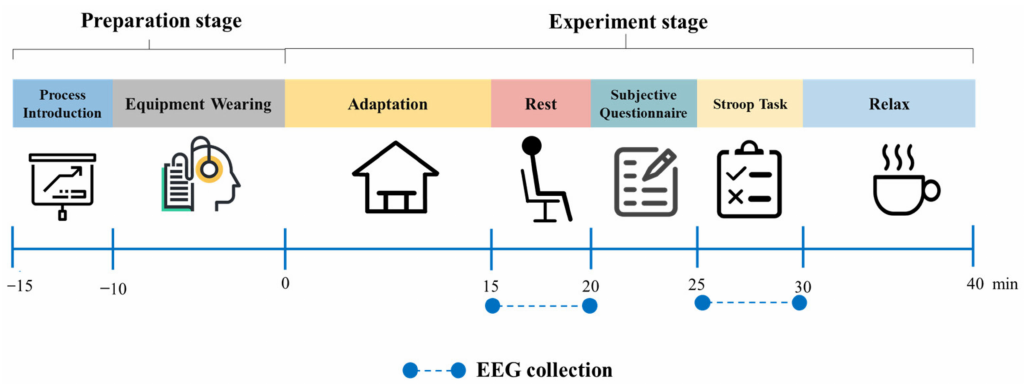
Figure 8. Experimental procedure. Table 5. Sequence table of working